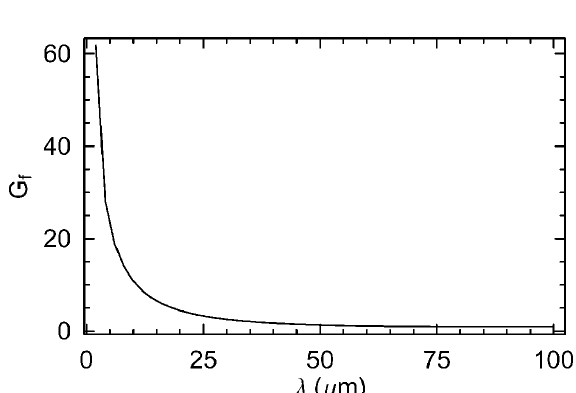
as a function of wavelength f (cid:1) 3 : 0 (cid:4) 10 (cid:3) 6 p